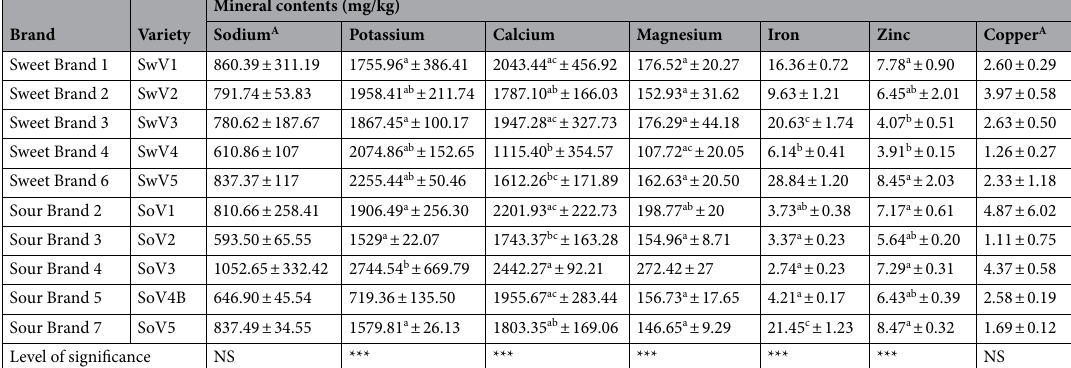
Table 2. The mineral contents in Bangladeshi yogurt of different brands and tastes (sweet and sour). SwV = Sweet variety, SoV = Sour variety, Mean values with different superscripts ( a, b, c, ac, ab, bc ) in the same column differed significantly while those left with no superscripts differed with all, A = No mean values showed any significant difference among each other hence were left single i.e. without any superscripts, *** = Significant at 5% level ( P < 0.05), NS = Non-significant, The values of all parameters were shown as mean ±